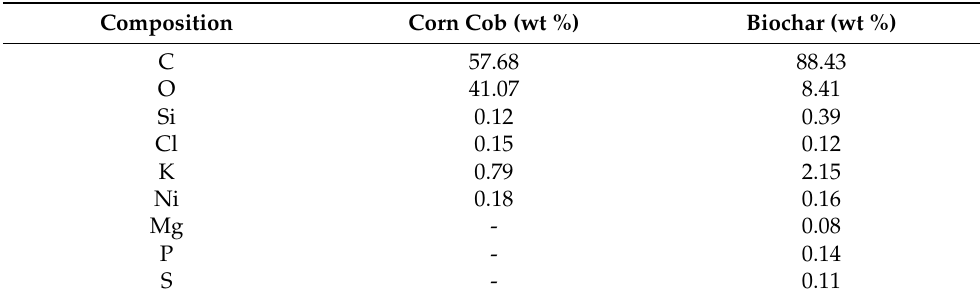
Table 2. Elemental compositions of biomass and biochar.